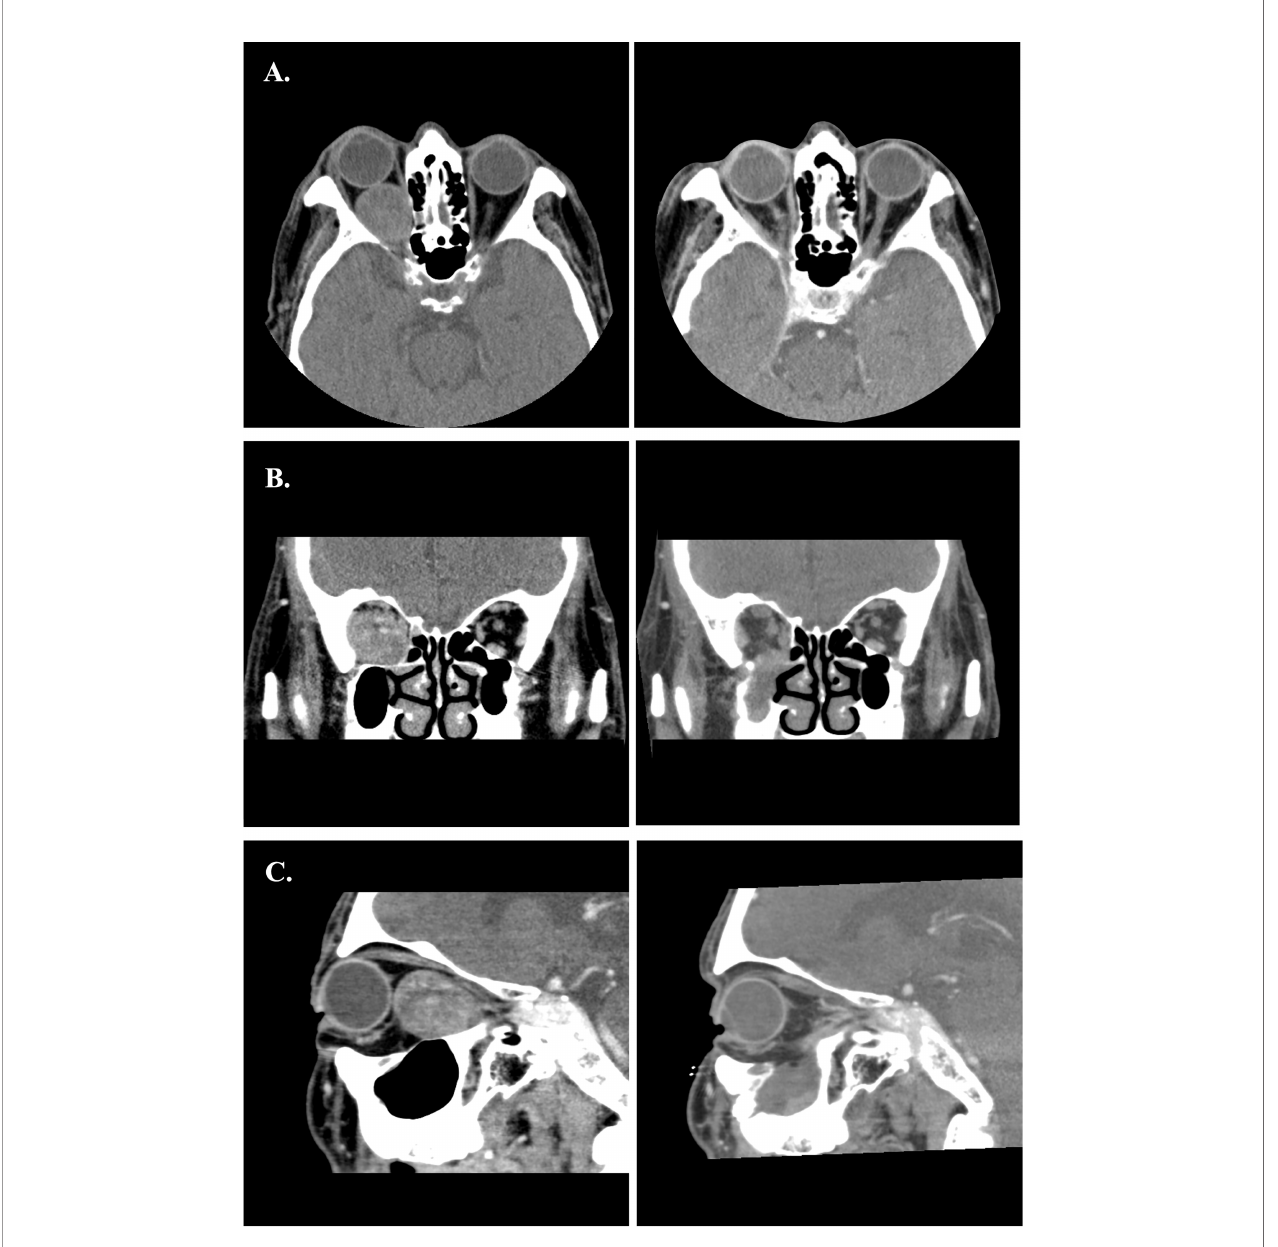
FIGURE 8 | (A – C) Preoperative and postoperative images of Case 1. The left-side axial, coronal and sagittal images were the preoperative CT scans. The right-side postoperative CT images showed normal extraocular muscles position and well restored orbital